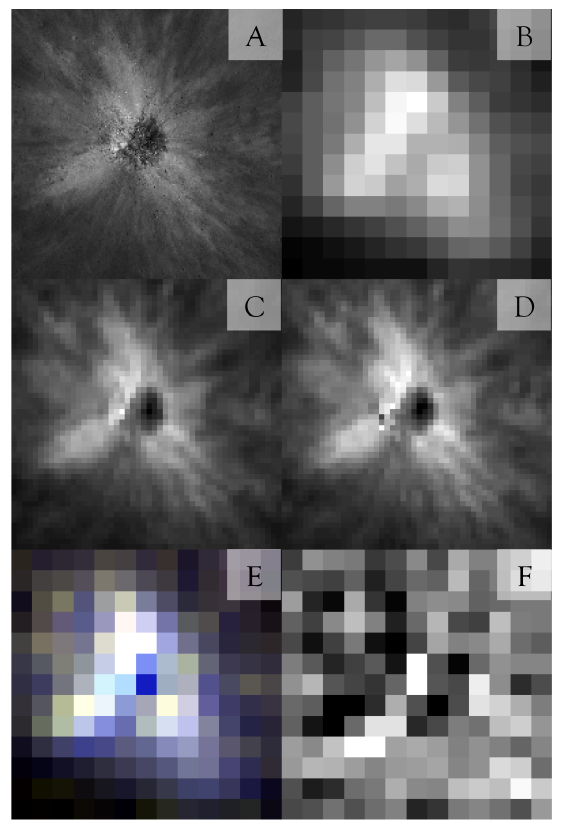
Figure 2: South Ray - A) Pan - 16 m/px, B) MS UV 1 - 256 m/px, C) MS Vis 1 - 64 m/px, D) MS Vis 5 - 64 m/px, E) MS composite image (red: Vis 5, green: Vis 1, blue: UV 1) - 256 m/px F) MS ratio image: UV 1 / Vis 1 - 256 m/px.